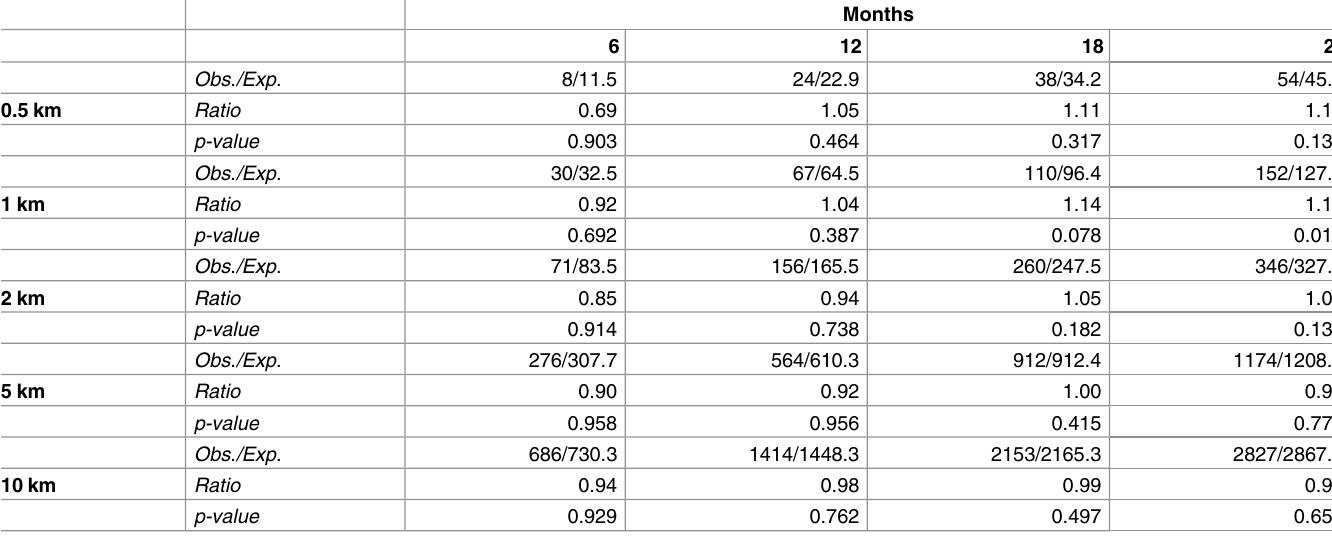
Table 1. Results of Knox tests of cases of leukemia at place and time of birth of children 0–15 yearsof age.